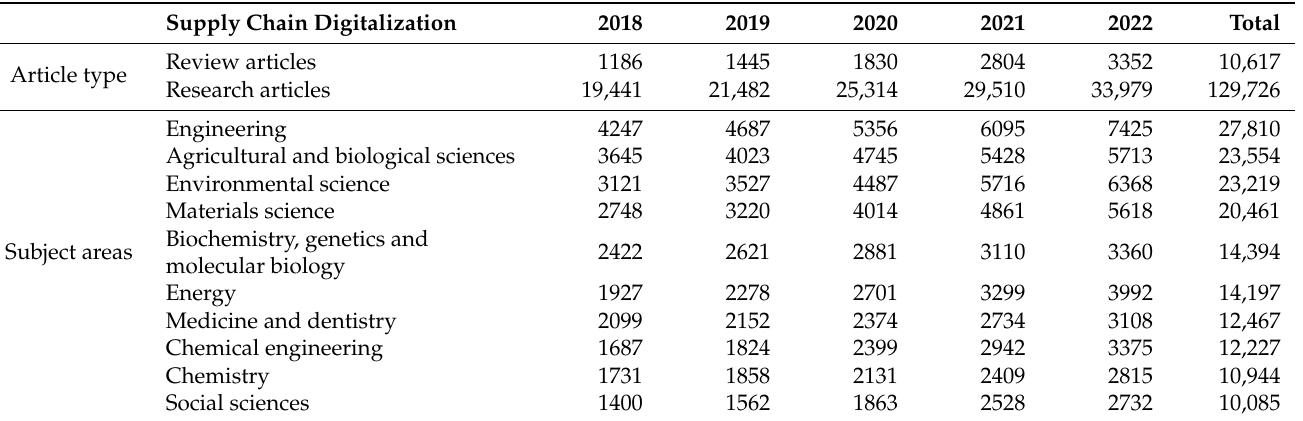
Table 1. Analysis of the degree of research interest in production digitization (ScienceDirect database, December